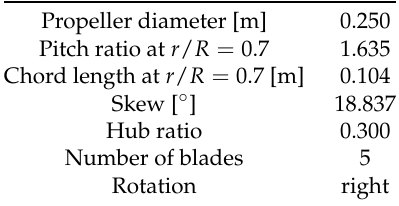
Table 1. VP1304 propeller geometry. [30].